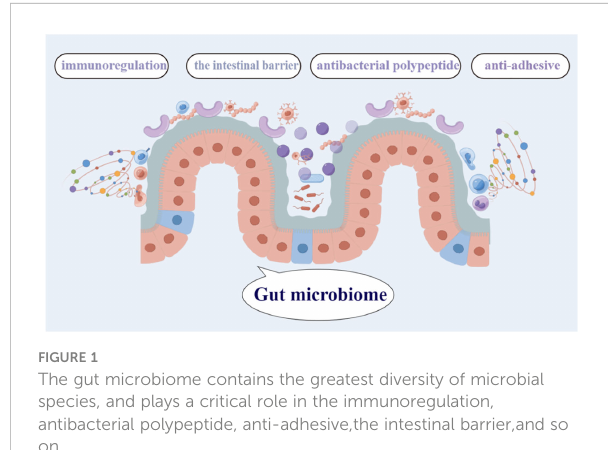
FIGURE 1 The gut microbiome contains the greatest diversity of microbial species, and plays a critical role in the immunoregulation, antibacterial polypeptide, anti-adhesive,the intestinal barrier,and so